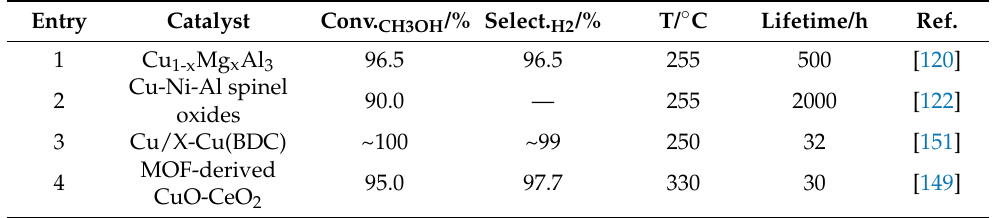
Table 4. Emerging materials for copper-based